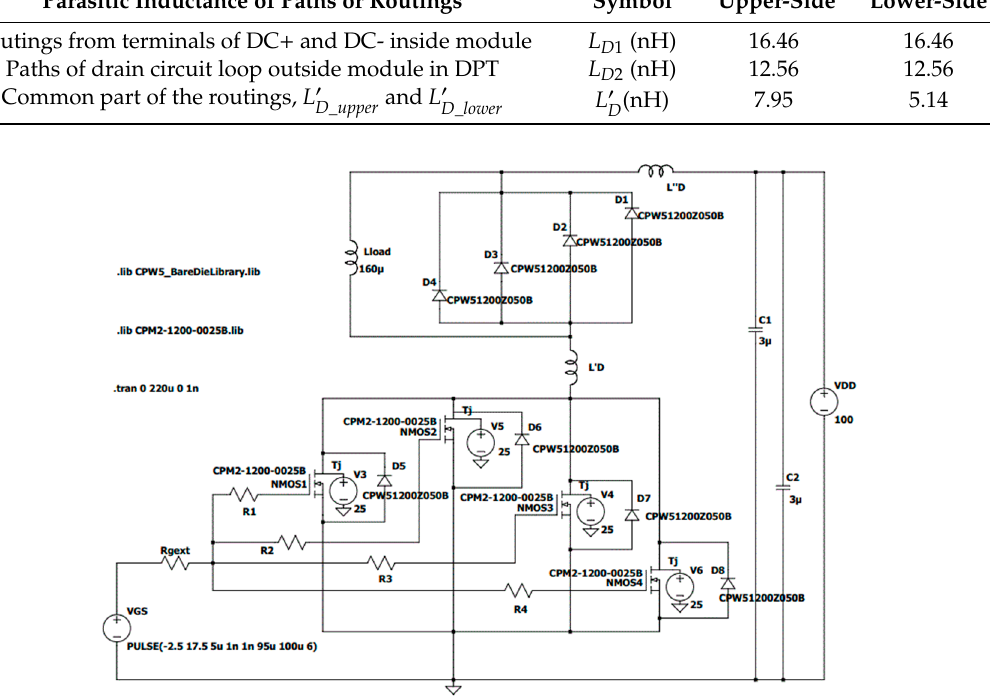
Figure 12. The diagram of schematic circuit for simulation by LTspice.